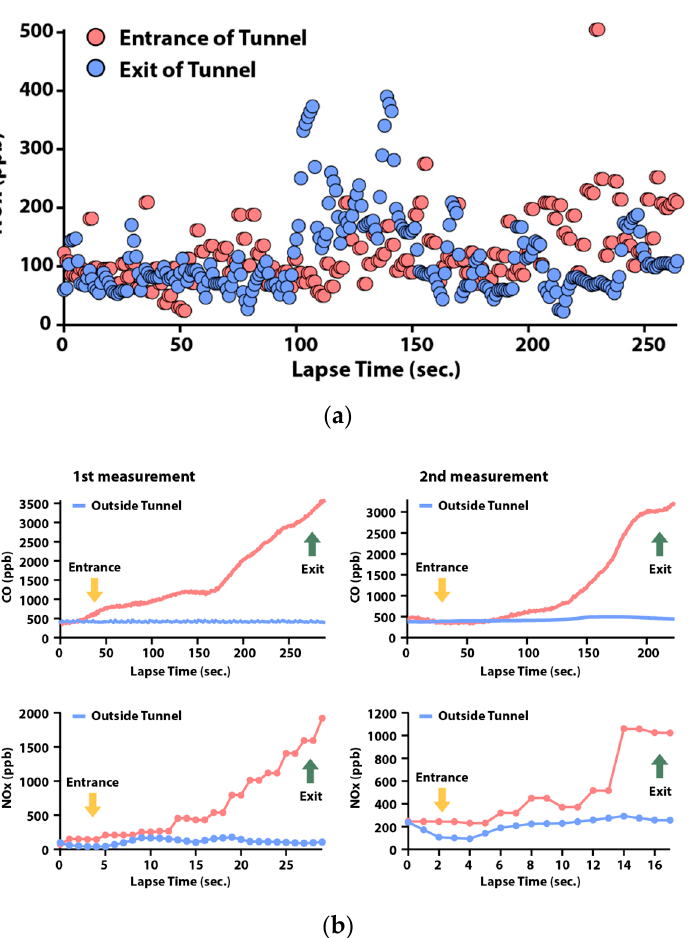
Figure 2. ( a ) Concentration of CO and NOx at 2.3 m from the tunnel entrance and the 20 m from the tunnel exit as the sampling point at same time, ( b ) concentration of CO and NOx by the moving vehicle.